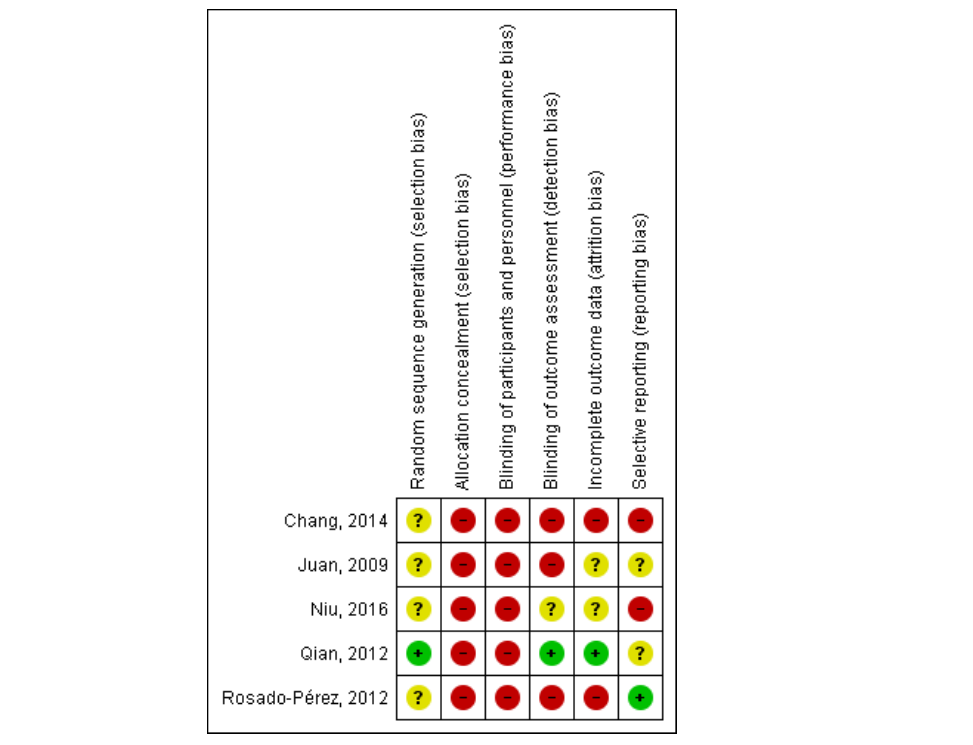
Figure 3. Summary diagram of risk of bias for randomized studies. Table 3. Risk of bias in non-randomized interventions (ROBINS-I tool).